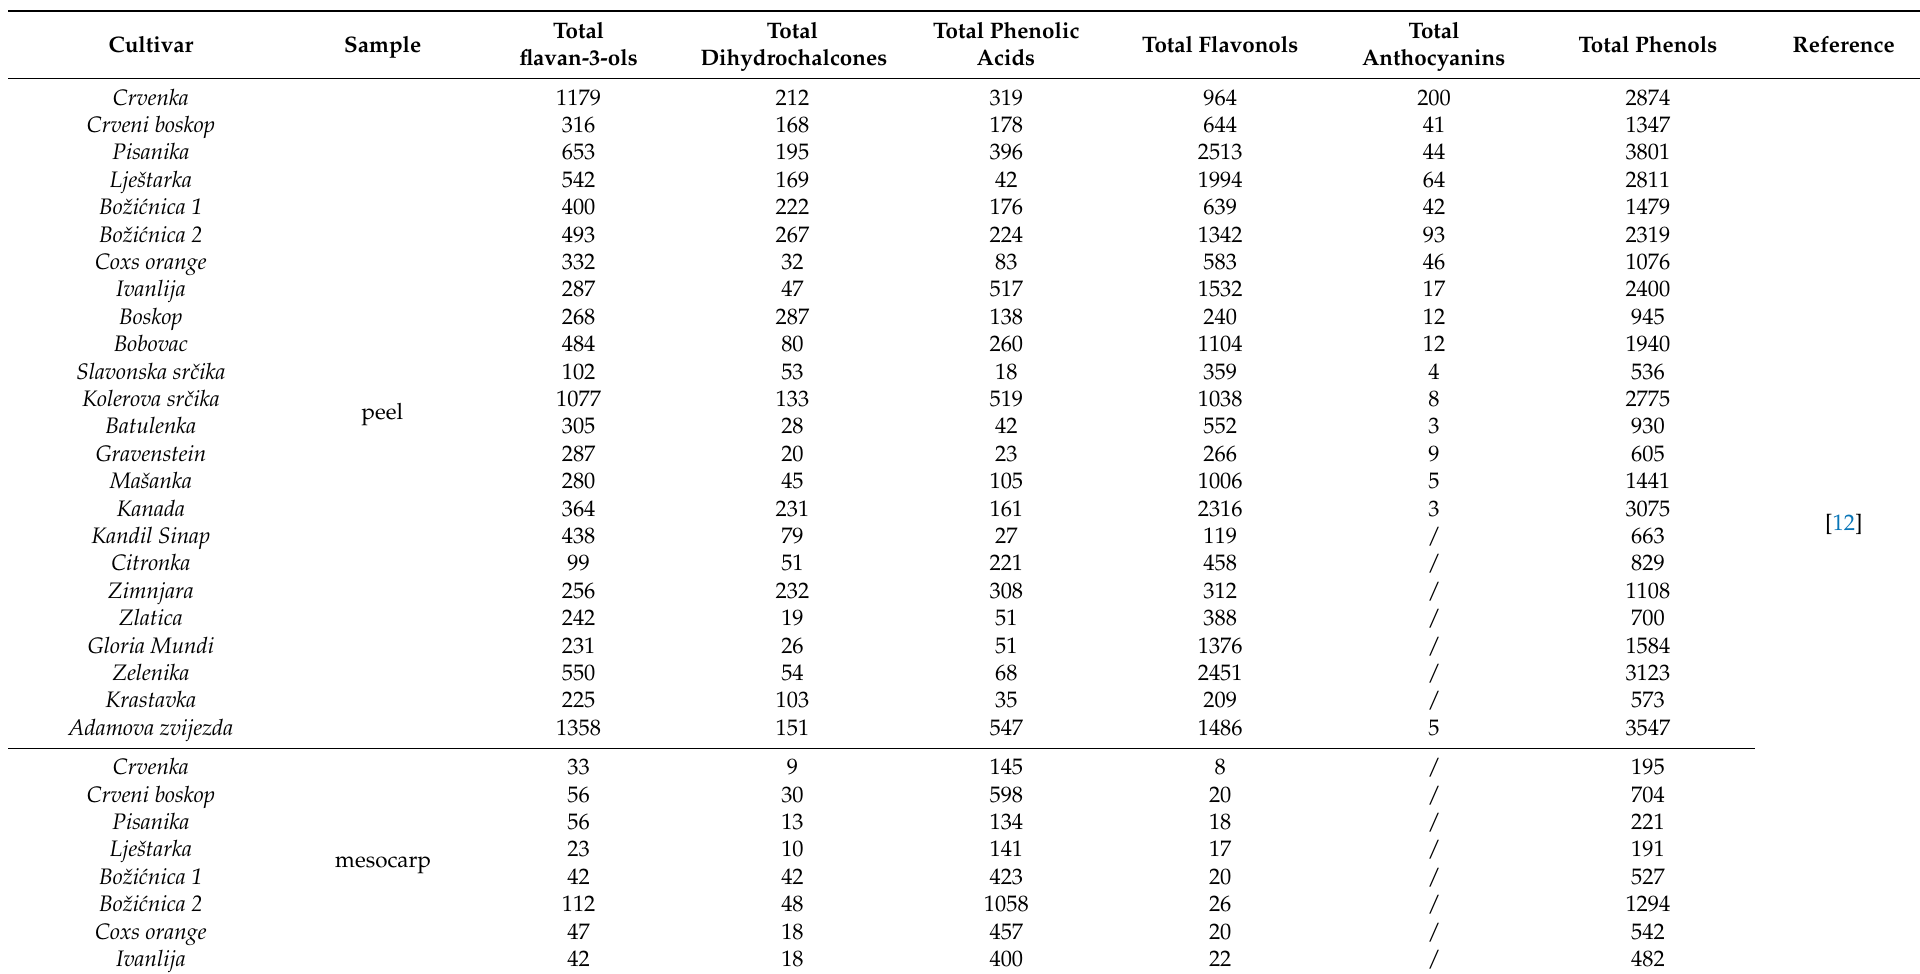
Table 4. The main polyphenolic subgroups of old apple cultivars grown in Croatia (mg kg − 1 fresh sample